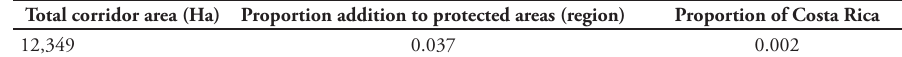
Table 2. Area covered by all proposed corridors, currently protected lands and proportional contribu- tions of these lands relative to current protected areas and Costa Rica as a